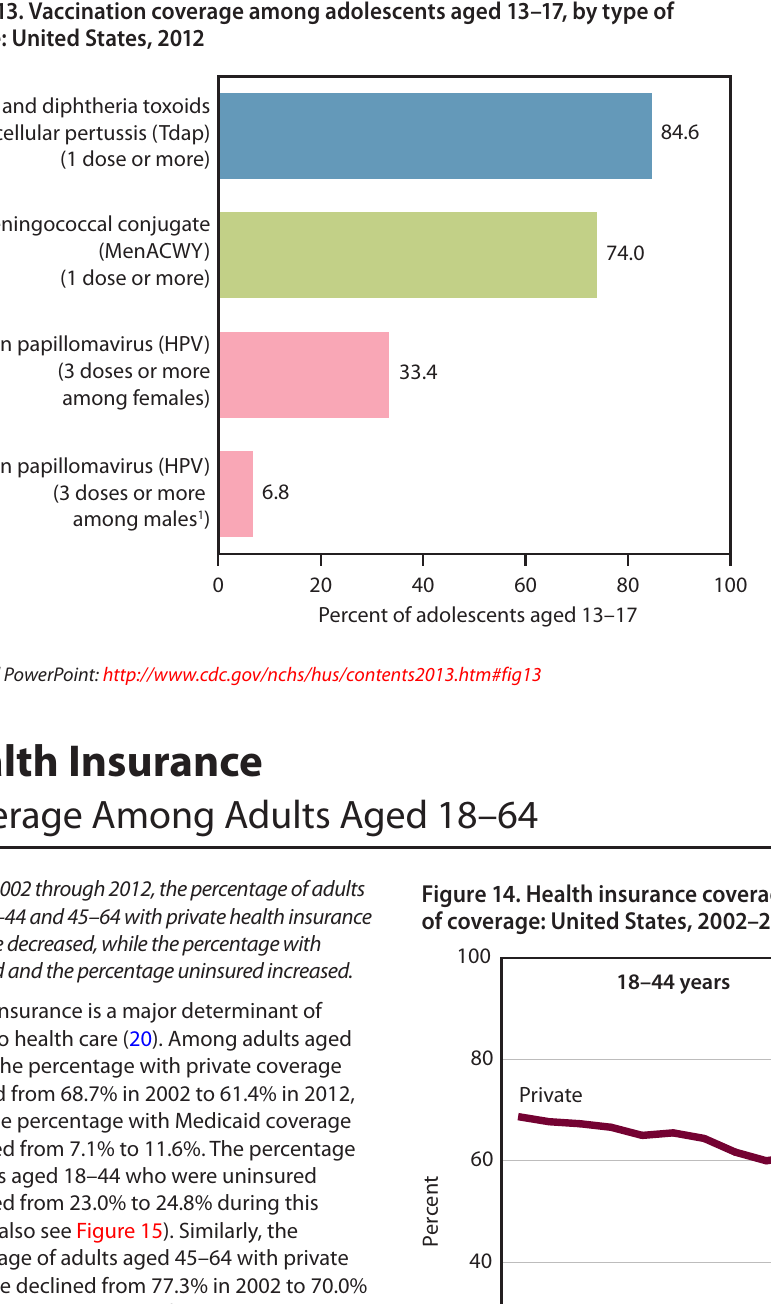
Figure 13. Vaccination coverage among adolescents aged 13–17, by type